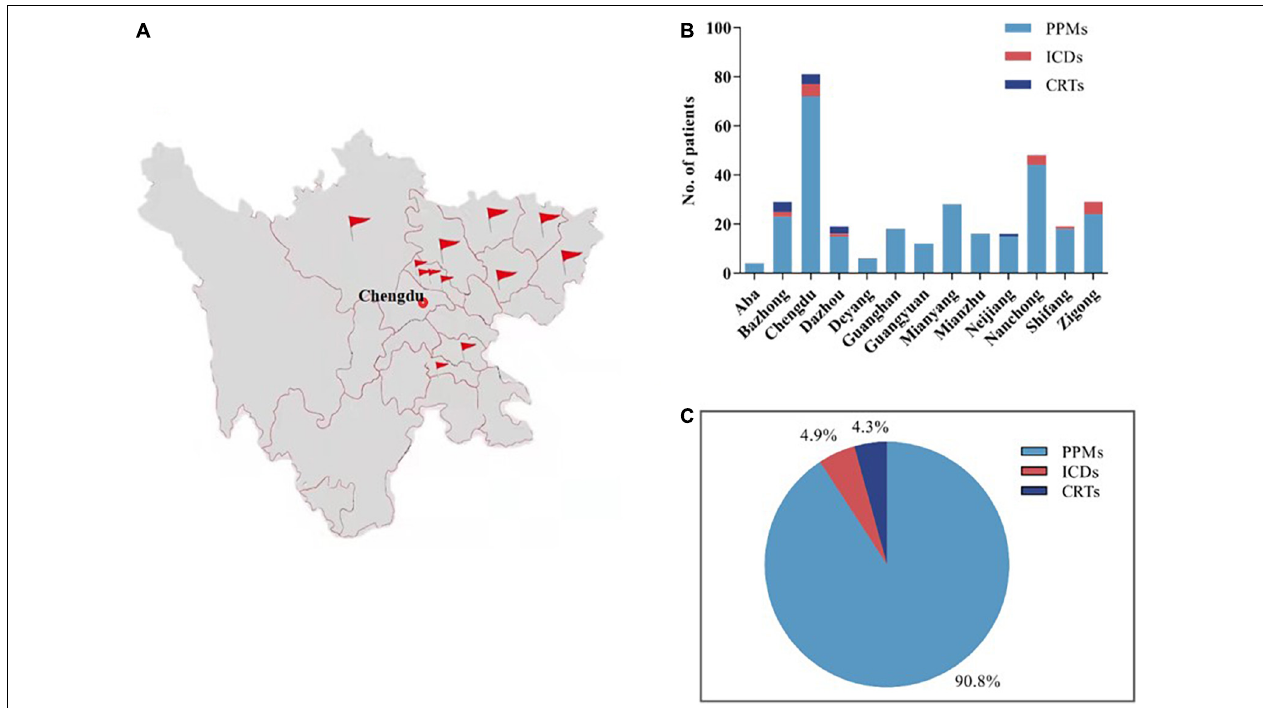
FIGURE 2 | The general profile of the present study. A total of 325 patients from 13 hospitals in Sichuan, China, were enrolled in this study (A,B) , including 295 (90.8%) patients with PPMs, 16 (4.9%) patients with ICDs and 14 (4.3%) patients with CRTs (C) . PPMs, permanent pacemakers; ICDs, implantable cardioverter defibrillators; CRTs, cardiac resynchronization therapies.